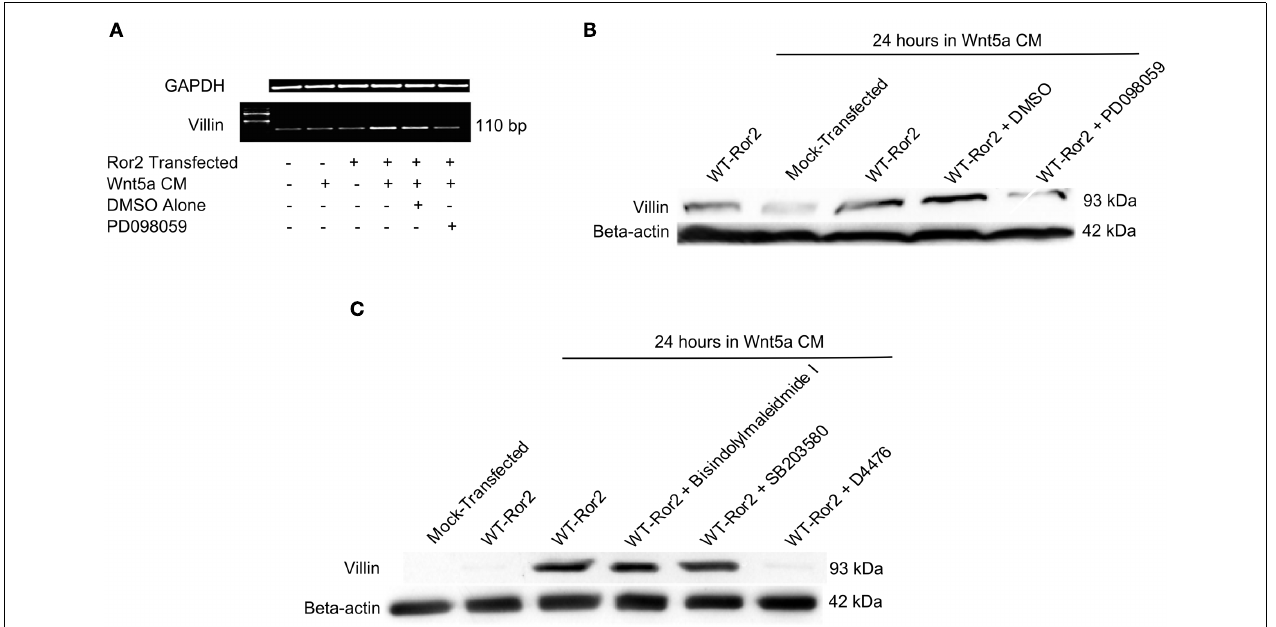
FIGURE 3 |Wnt5a interaction with Ror2 upregulated villin transcript and increased protein expression via an ERK1/2-dependent mechanism. (A) HT29 cells were transfected with Ror2 (no plasmid as control) and treated withWnt5a and/or PD 098059 (1 μ M), DMSO (as shown in legend). RT-PCR analysis forVillin (GAPDH as control) was performed. (B) Villin protein expression was upregulated inWT Ror2-transfected cells treated withWnt5a conditioned media for 24h, compared to mock-transfected and/or untreated cells. In the presence of a specific MEK-1 inhibitor (PD 098059; 1 μ M), the increased villin protein expression was lost.Western blotting for β -actin was performed as an